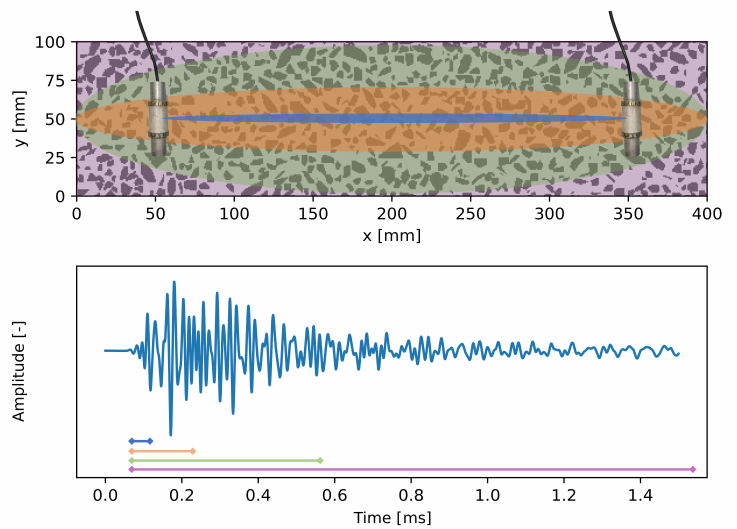
Figure 1. Ultrasonic recording ( bottom ) and the schematic explanation of CWI with two US trans- ducers in a concrete model ( top ): when analyzing only the first arriving waves, the measurements are sensitive only to the area around the direct path between source and receiver (blue). As more scattered waves are included, the area increases (orange, green). Referring to the entire signal (purple), scattered waves from the entire medium are recorded at the